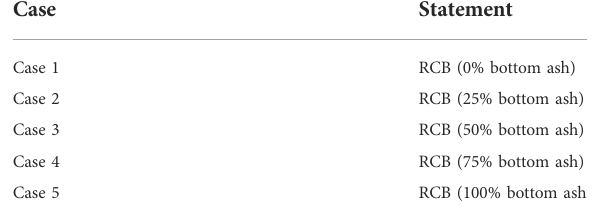
TABLE 5 RCBs for fi ve different experimental test cases.